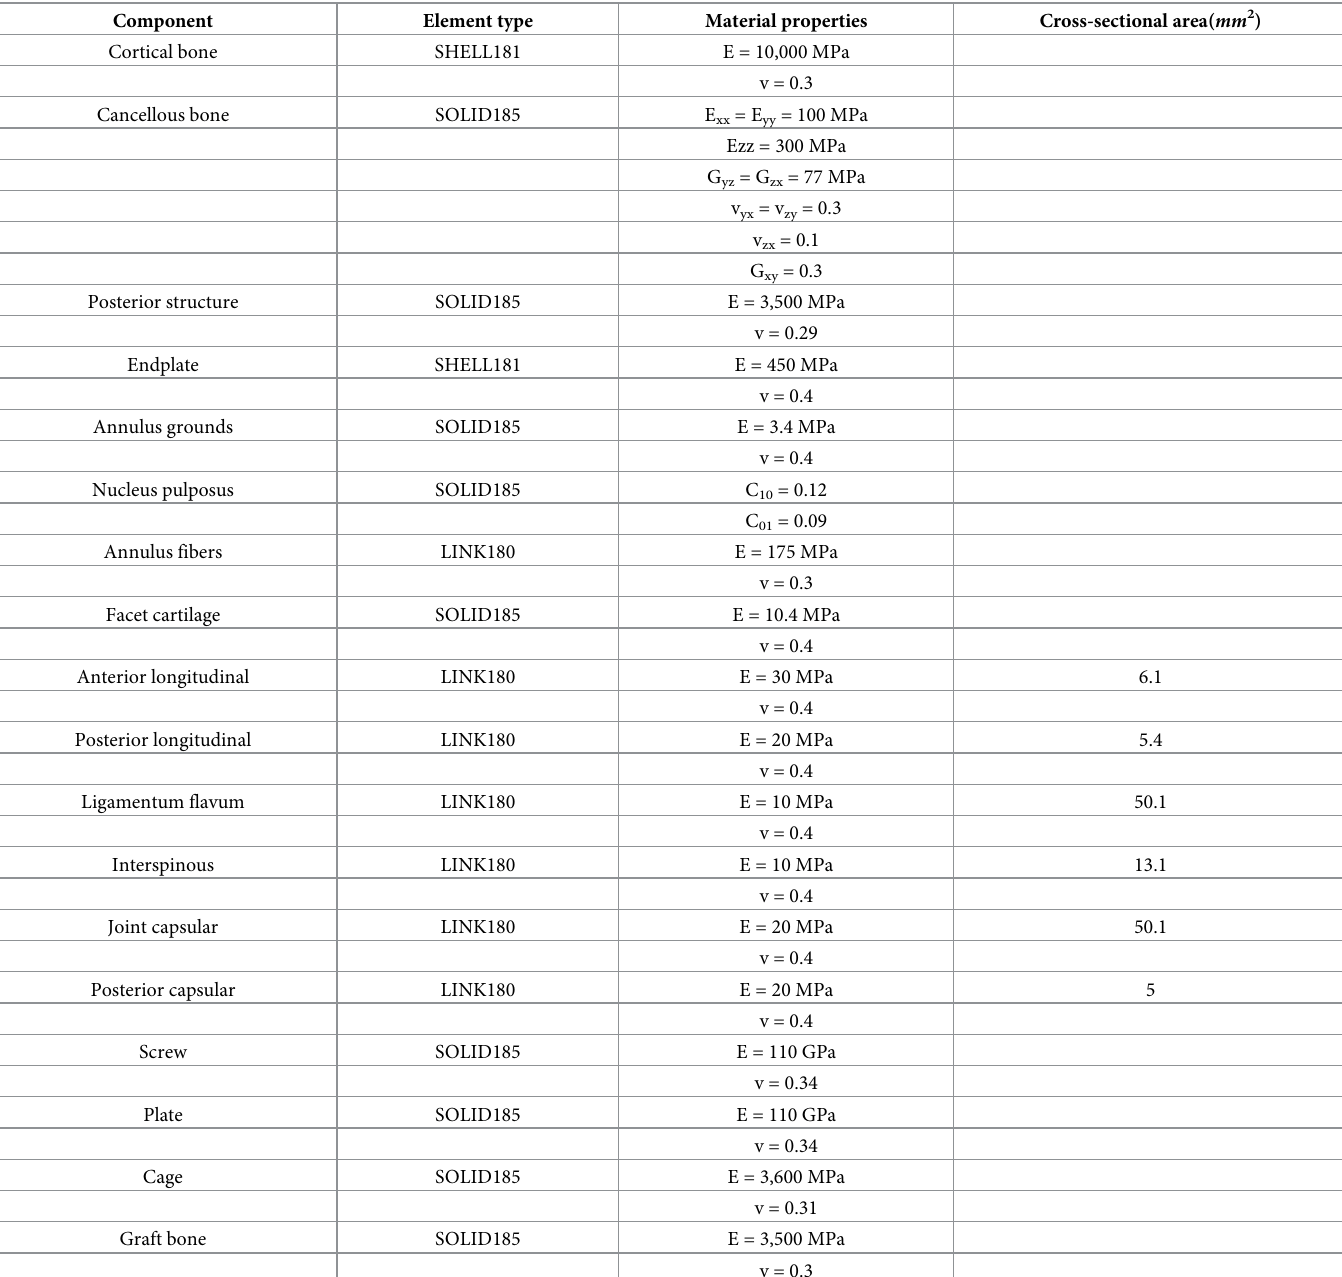
Table 1. Element type selection and material parameters of the cervical spine